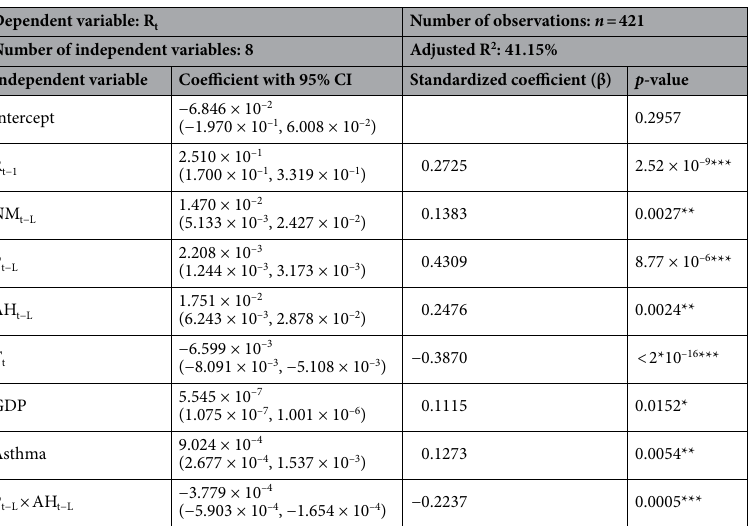
Table 1. Statistically significant independent variables that associate with dependent variable R across all 18 high infection provincial capital cities in China from 1 January to 20 March 2020. 1. P, AH, and NM are lagged and averaged by L = 14 days. 2. The standardized coefficient (also referred to as β coefficient) is calculated by multiplying the original regression coefficient by the ratio of the independent variable’s standard deviation to the dependent variable’s standard deviation. 3. * p -value < 0.05, ** p -value < 0.01, *** p -value <